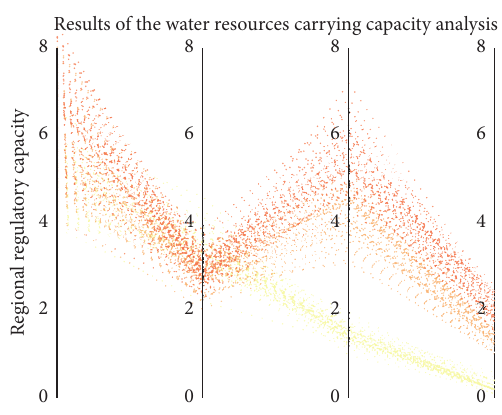
Figure 5: Results of the water resources carrying capacity analysis.